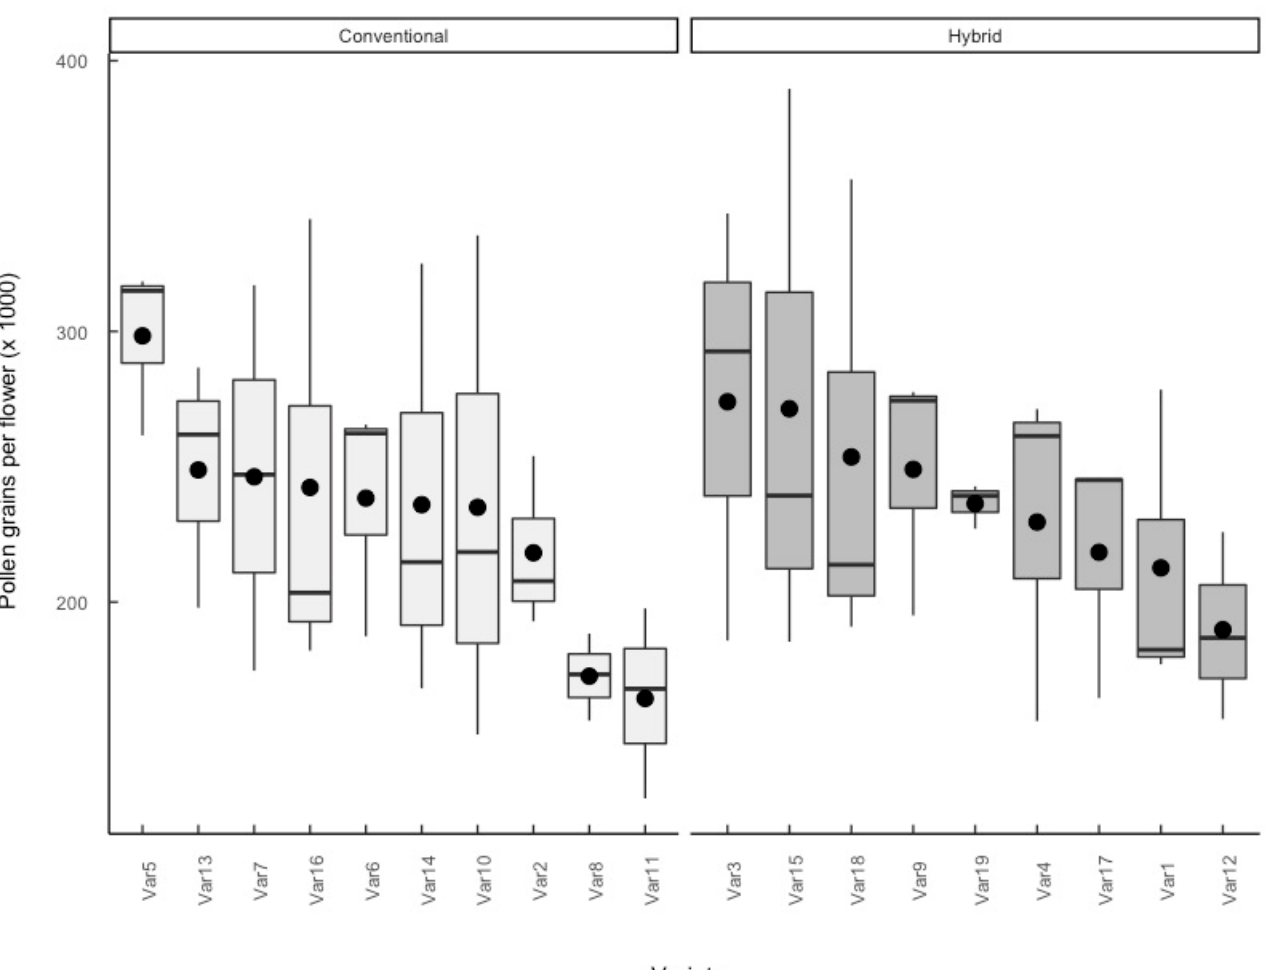
Figure 3. The number of pollen grains per flower in 19 oilseed rape varieties (n = 15 flowers). Black circles represent the mean values. Boxes around the median show the interquartile range. Whiskers extend to minimum and maximum values. Variety names have been anonymised by